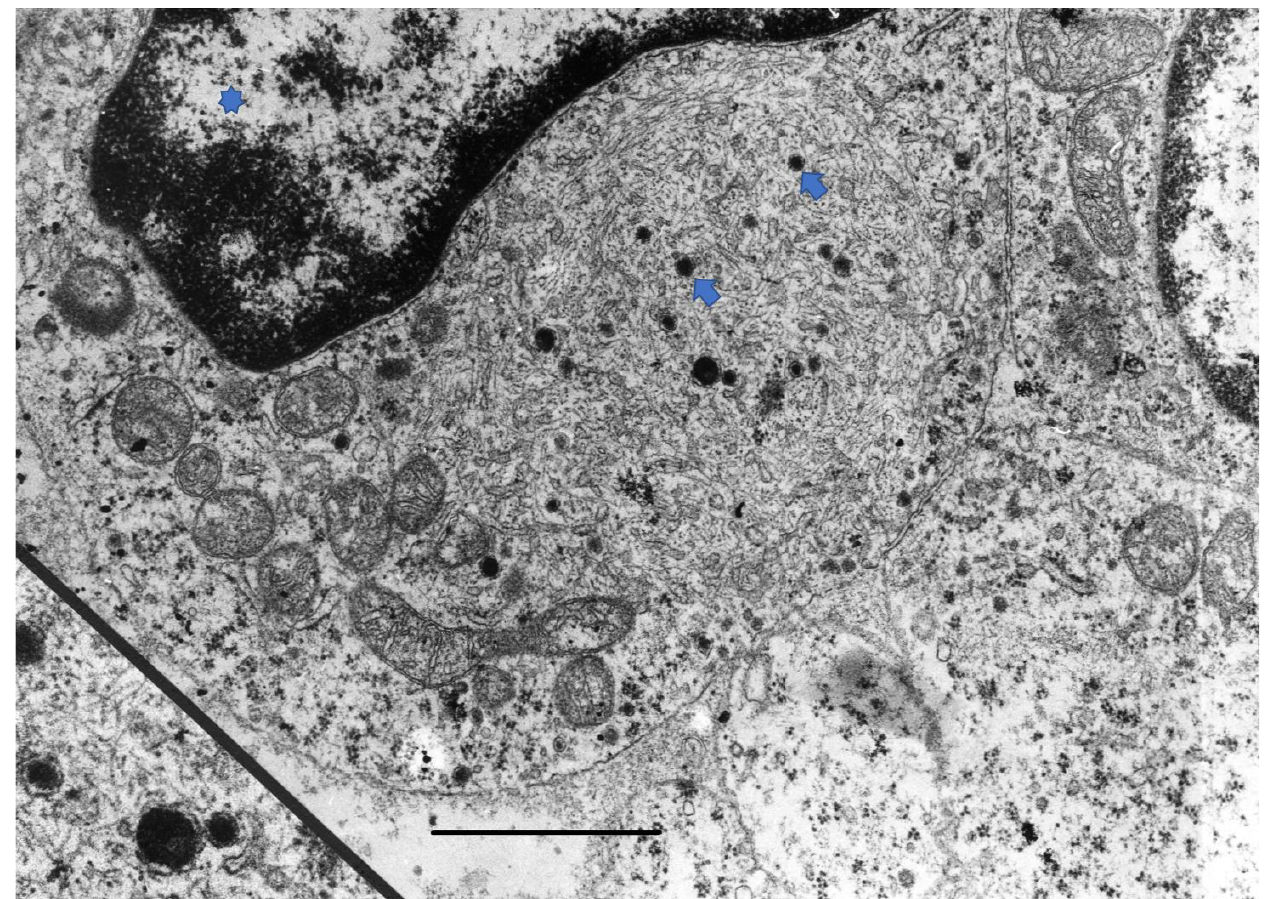
Figure 3. Electron microscopy of a MCC tumor cell * demonstrates electron-dense neuroendocrine granules in the cytoplasm. Asterisk: cell nucleus, Arrows: neuroendocrine granules. Magnification = × 28,980 and ×56,350. Bar = 500 nm.